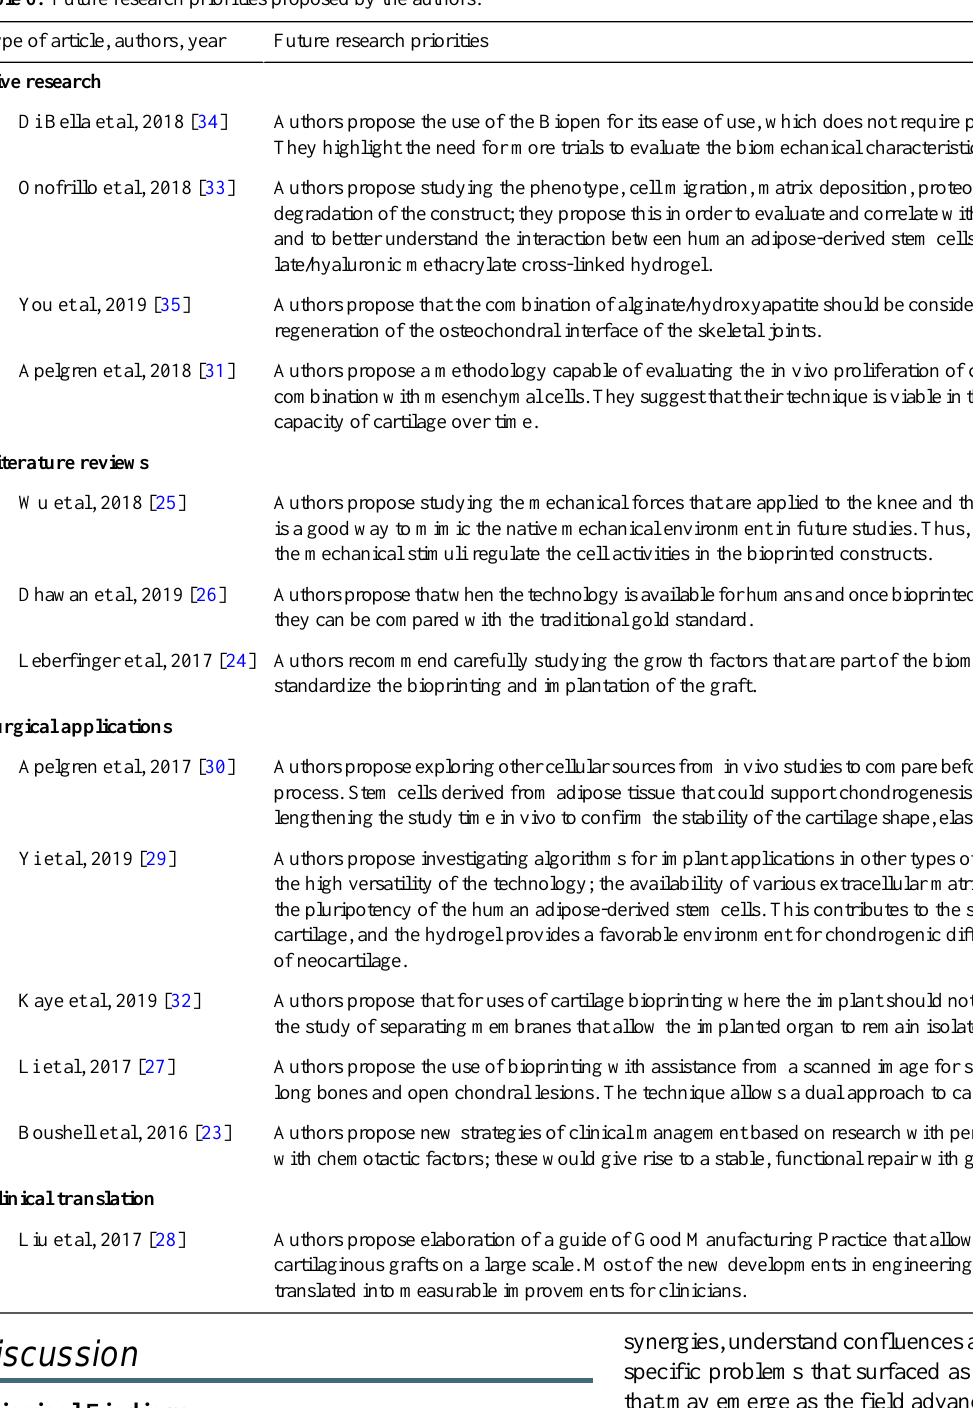
Table 6. Future research priorities proposed by the